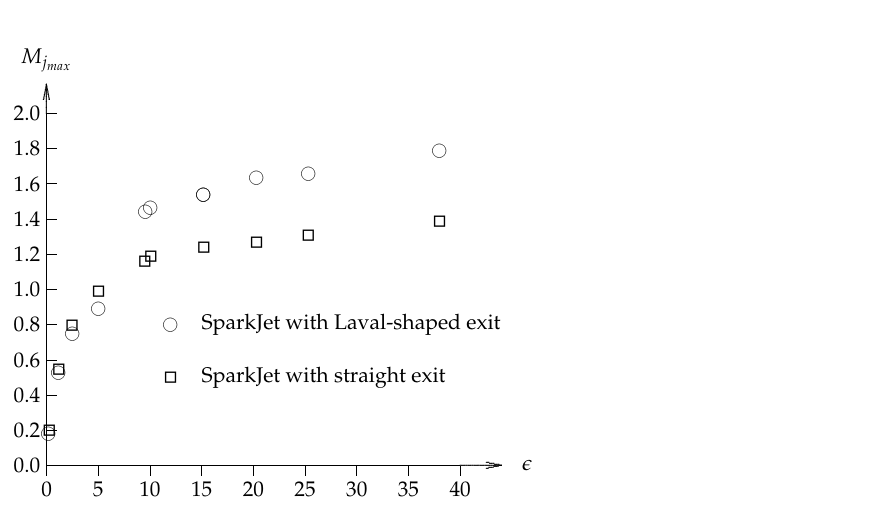
Figure 36. Comparison of the experimental and numerical simulation at quiescent air. Adapted from